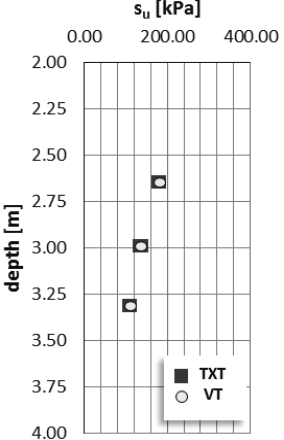
Fig. 5. A comparison of s u provided by reference methods Applying different values of N